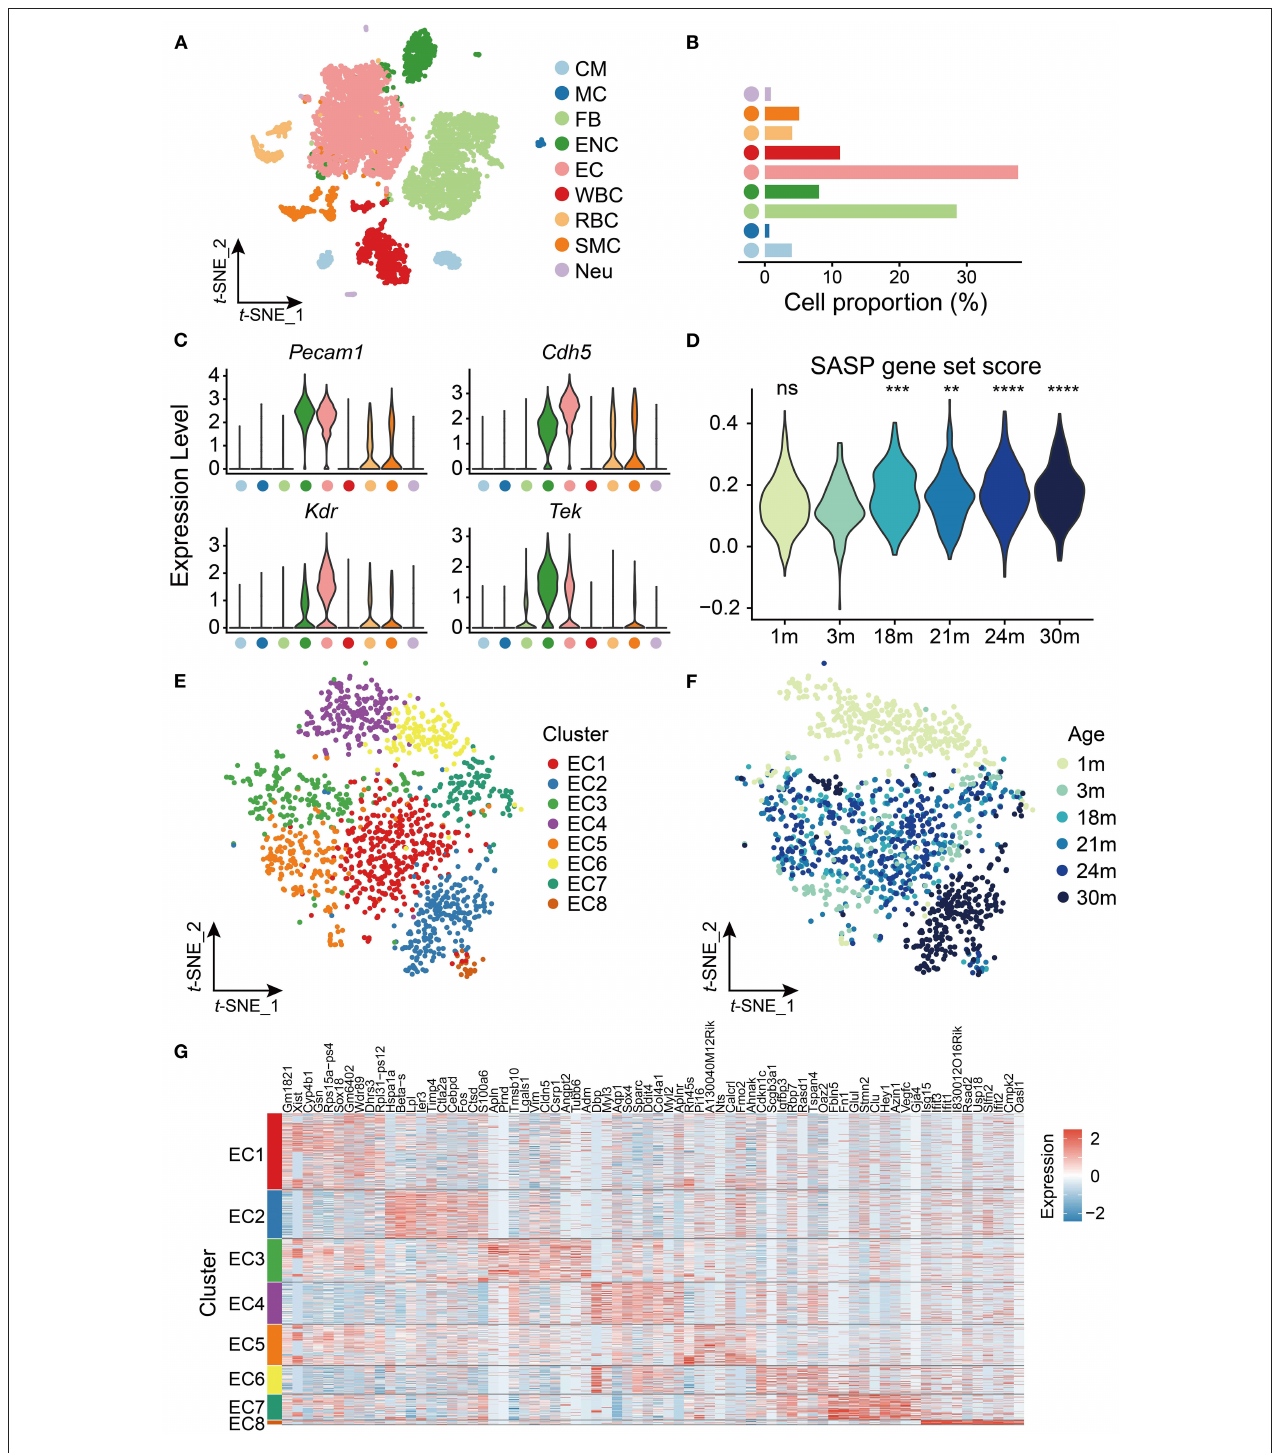
FIGURE 1 | scRNA-seq analysis of cardiovascular endothelial cells (ECs) during aging. (A) t -SNE plot showing nine cell types from heart and aorta. CM, cardiomyocyte; MC, mast cell; FB, fibroblast; ENC, endocardial cell; EC, endothelial cell; WBC, leukocyte; RBC, erythrocyte; SMC, smooth muscle cell; Neu, cardiac neuron. (B) Bar plot showing cell proportion of nine cell types from heart and aorta. (C) Violin plots showing expression of EC markers in the heart and aorta. (D) Violin plot showing the SASP gene set score is significantly increased with age in ECs. ns, not significant; ** p < 0.01; *** p < 0.001; **** p < 0.0001. (E) t -SNE plot showing eight clusters of ECs from heart and aorta. (F) t -SNE plot showing ECs from heart and aorta across the lifespan. (G) Heatmap showing top 10 markers expressed in each cluster of ECs from the heart and aorta.